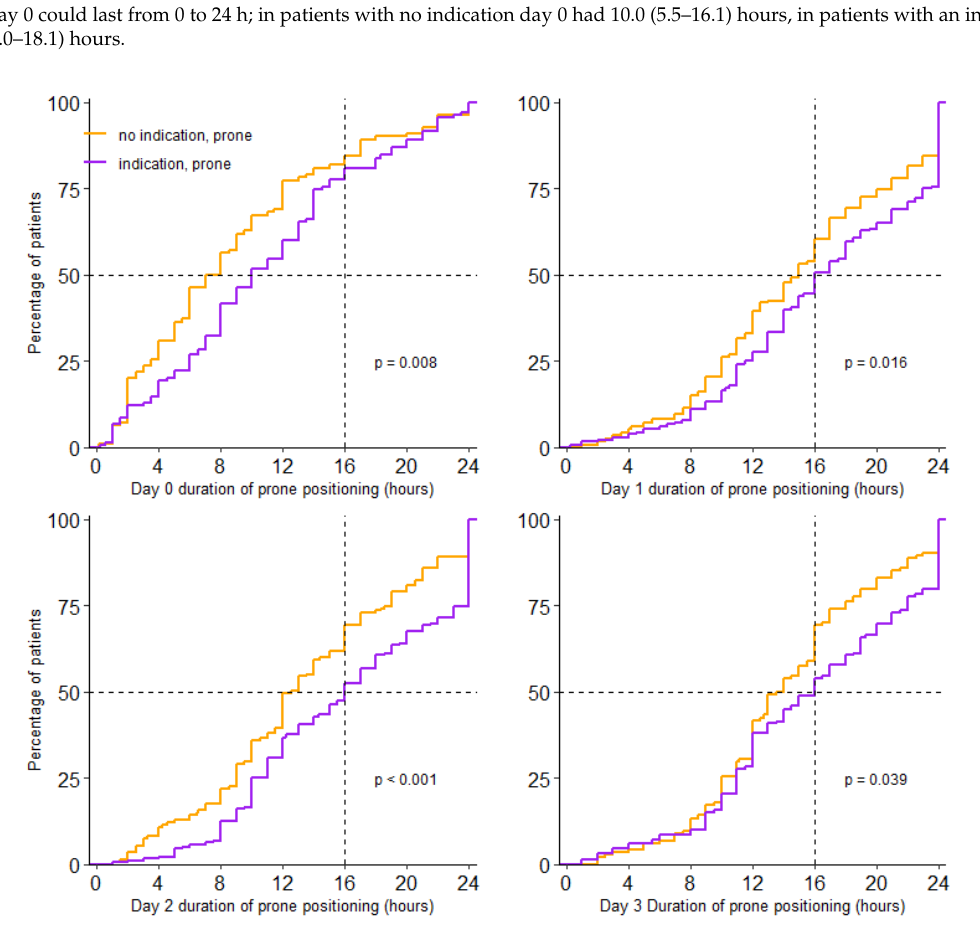
Figure 2. Cumulative distribution duration of prone positioning per day. Duration of prone positioning session for each patient on day 0 to day 3.